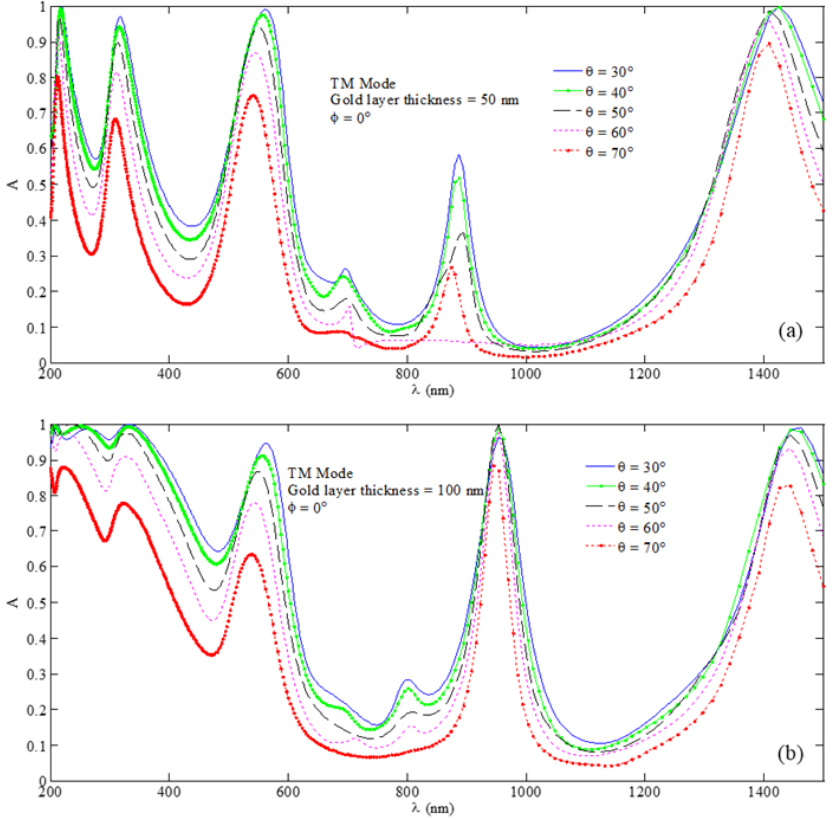
Figure 6. Absorption spectra for the butt-facing U-shaped MPA nanostructure under the TM wave excitation with ϕ = 0° incidence and corresponding to the cases of ( a ) 𝑑 = 50 nm and ( b ) 𝑑 = 100 nm with 𝑡 = 100 nm.